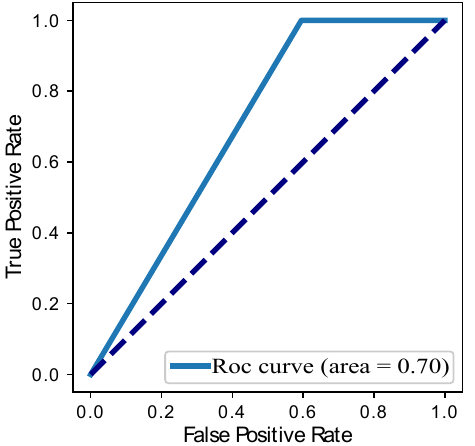
Figure 19. ROC curve of Random Forest (RF).